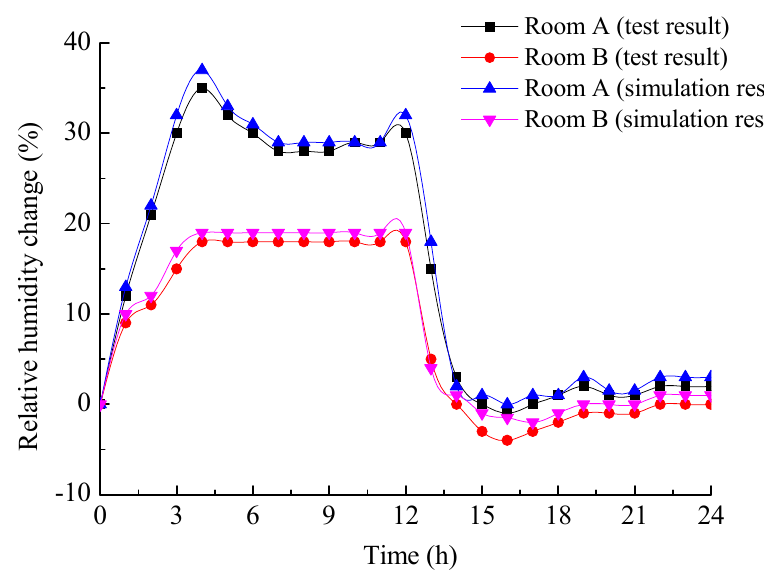
Figure 5. Relative humidity change comparison result.